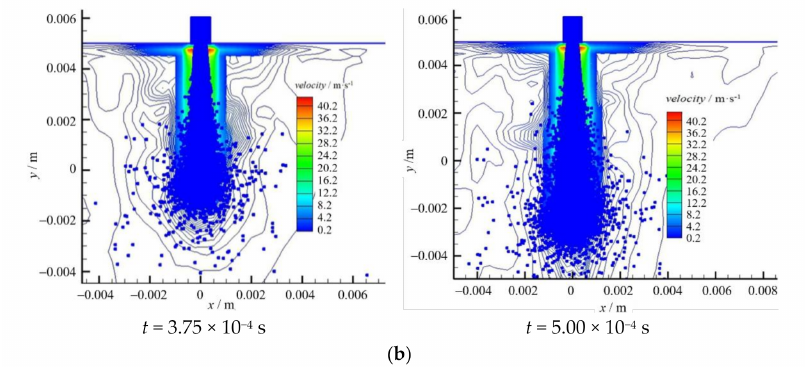
Figure 15. Results of the coupling of the liquid jet in the static airflow at an injection speed of 20 m/s (liquid particles, pressure contour of z = 0 plane, velocity vector): ( a ) maps of the pressure contour change over time; ( b ) maps of the velocity contour change over time at the liquid jet velocity of 20